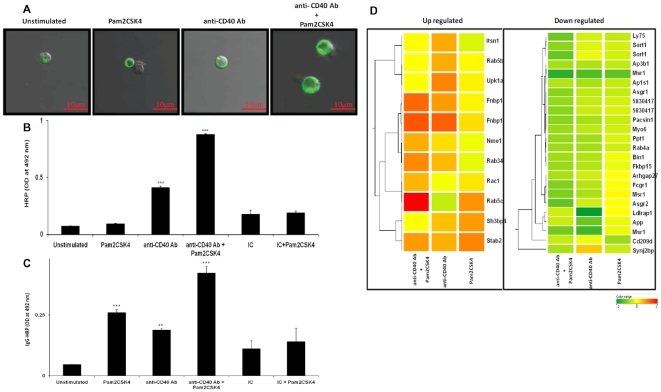
TLR-2 stimulated RB cells exhibits enhanced fluid phase pinocytosis and receptor mediated endocytosis on CD40 costimulation.RB cells were stimulated with Pam2CSK4 and anti-CD40 Ab for 16 h. (A) For confocal studies, cells were pulsed with BSA-FITC and the extent of antigen uptake is depicted through ‘Z’ stacks of stimulated B cells with respect to controls. Pictures shown here are representative of three independent experiments. Scale bar: 10 µm. (B, C) Stimulated B cells were pulsed with soluble HRP (B) or IgG-HRP (C) after stimulation and cells were washed and lysed. HRP uptake was measured colorimetrically. Values were normalized using experimental blanks and control cells which were maintained on ice. The data represents mean ± SEM of three individual experiments. (D) Dendrograms showing modulations in the expression of genes involved in endocytosis. Genes showing upregulation (upper panel) and downregulation (lower panel) were plotted with respect to control (unstimulated; assigned value ‘0’). P values are indicated in the text. Scale bar: −2 to +2. ‘*’, ‘**’, ‘***’ indicates p<0.05, p<0.01, p<0.001 respectively.